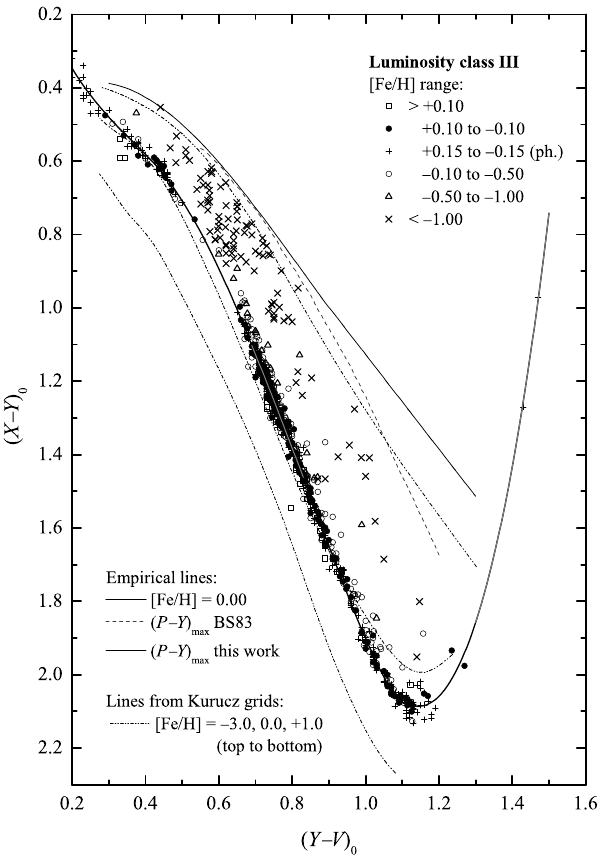
Fig. 6c. X – Y vs. Y – V diagram for giant stars. Symbols as in Figs. 4 a,b.